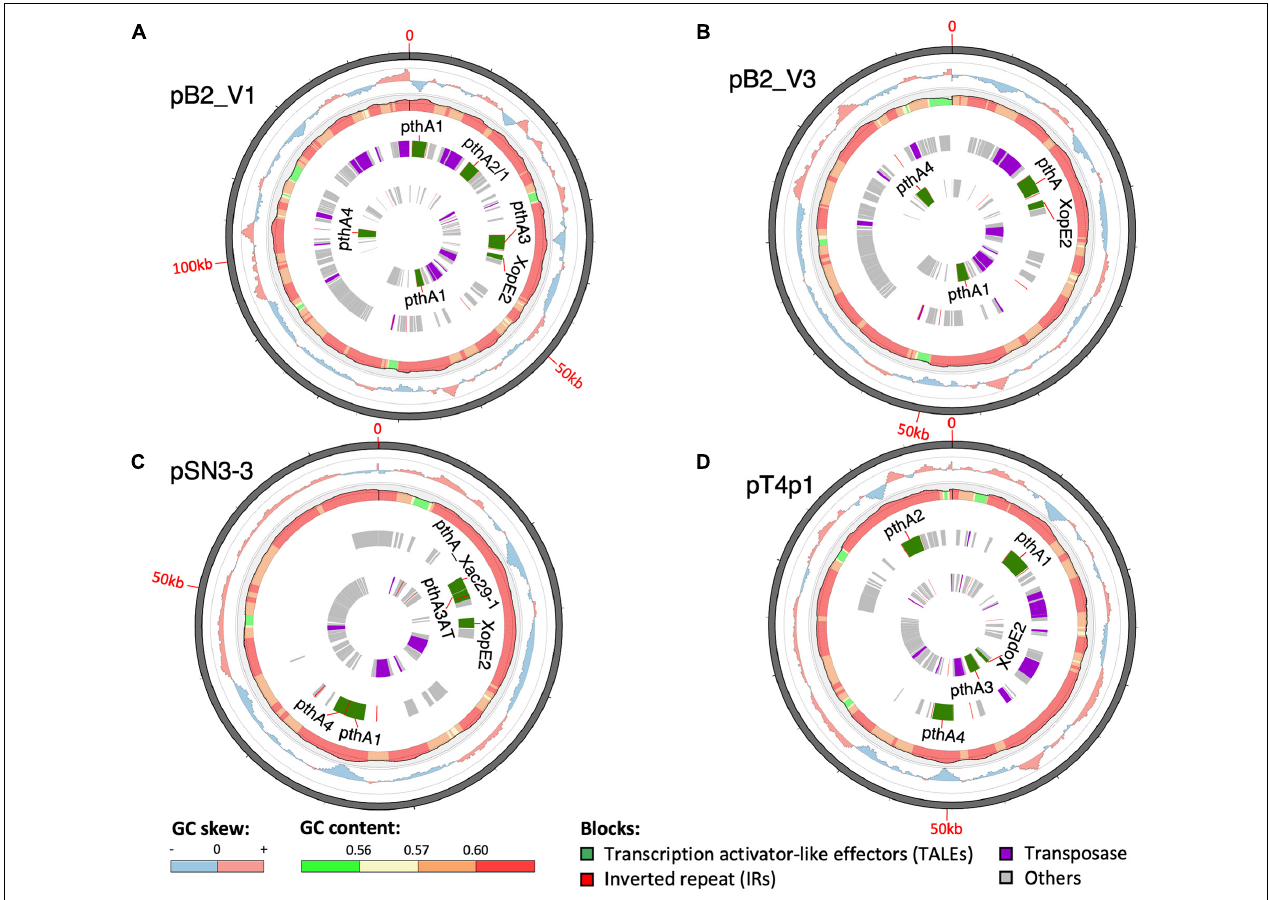
FIGURE 4 | Plasmid organization. (A) pB2_V1, (B) pB2_V3, (C) pSN3-3, and (D) pT4p1. Circles from outermost to innermost represent: (1) GC skew, (2) GC content, (3) reverse, and (4) forward direction of repetitive sequences. Green: TALEs. Red: inverted repeats. Purple: transposase. Gray: other CDS/genes: